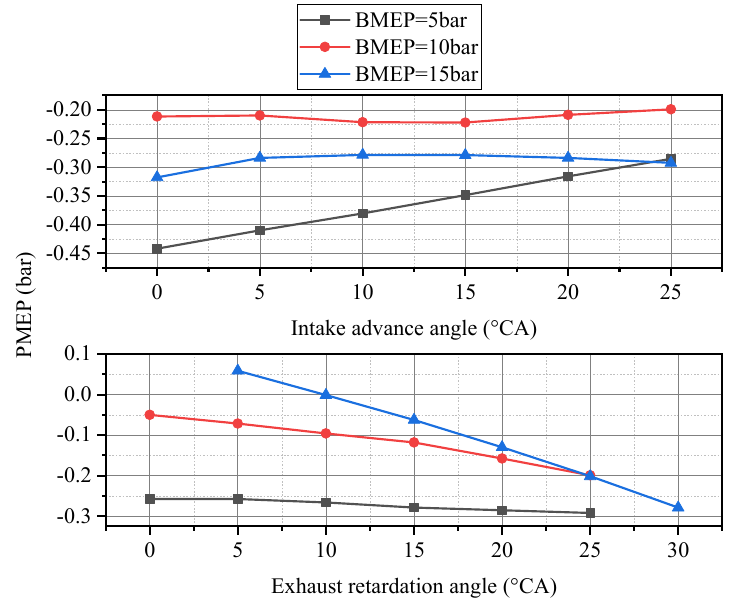
Figure 5. PMEP (Pumping Mean Effective Pressure) versus intake advance angle under baseline EVC, and PMEP versus exhaust retardation angle under the Miller cycle at different points of operation during the test.